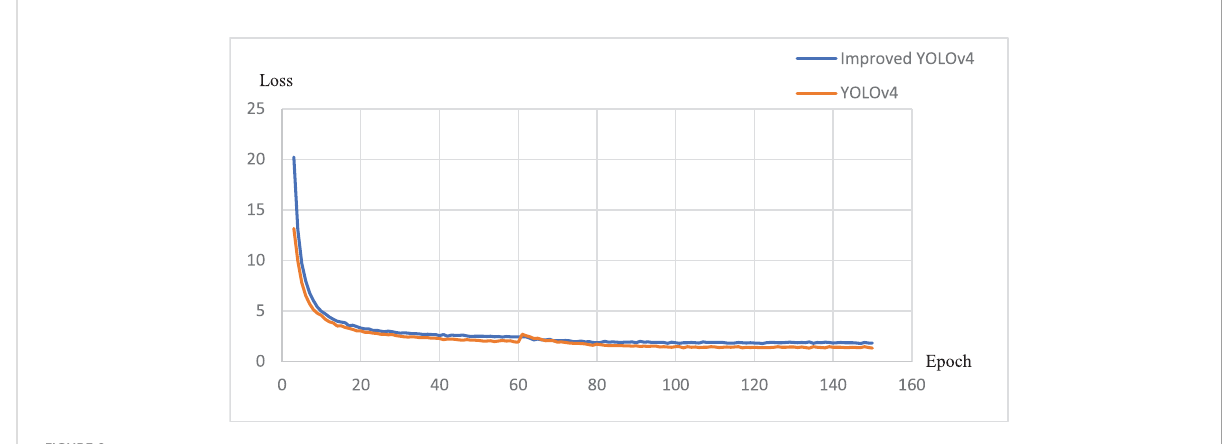
FIGURE 9 Loss changes during